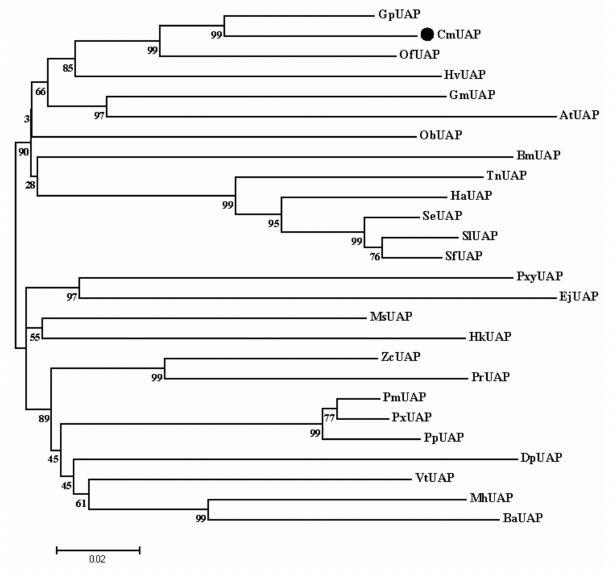
Figure 3. A cluster dendrogram of UAPs from 26 lepidopterans. The diagram was